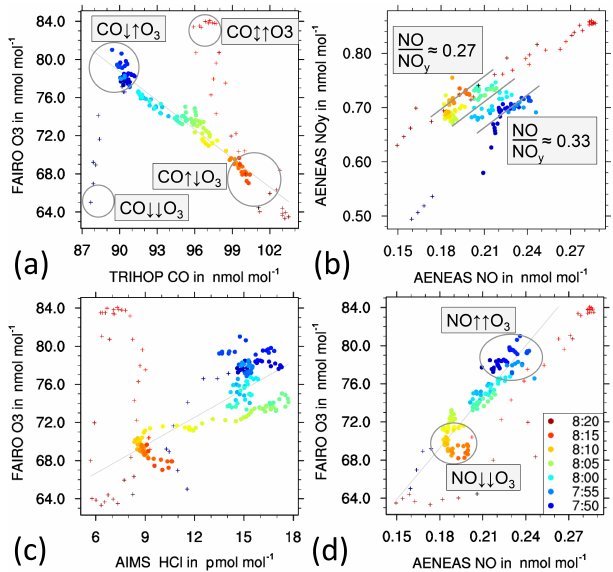
Figure 6. Tracer–tracer relations, as observed during one transect through the ASMA fringe. Colours indicate the time of measure- ment, filled circles highlight the first period of interest (POI3), grey lines are linear fits to those data (a, c, d) or hand-drawn markings discussed in the text (b) , and crosses show data just before and after POI3. Reservoirs referred to in the text are marked by grey